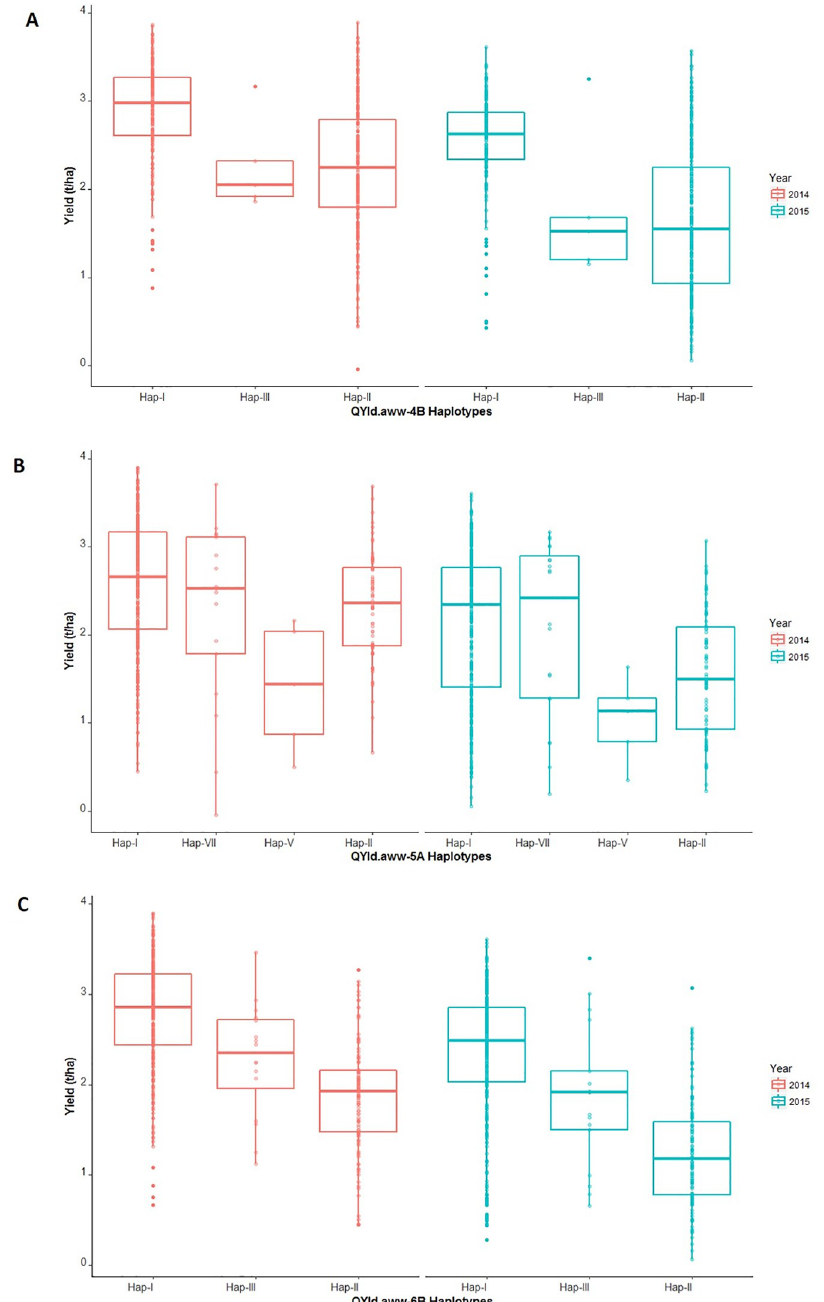
Fig 2. Boxplot of yield in 2014 and 2015 for accessions with different alleles at yield QTL. A– QYld . aww-4B , B– QYld . aww-5A and C– QYld . aww-6B